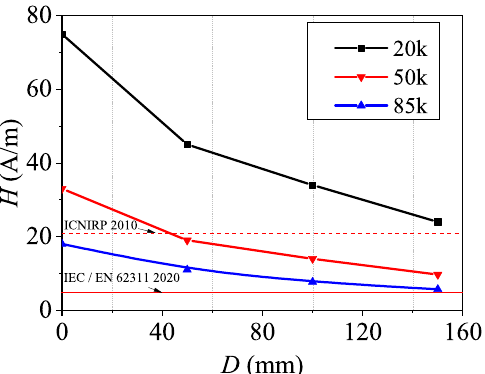
Figure 10. Curves of the H -field strength of the human body versus transfer distance at various frequencies.